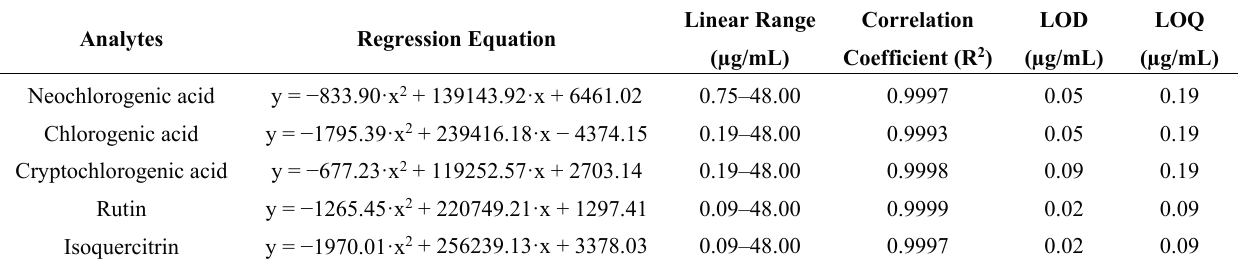
Table 1. Calibration curves, linearity, limits of detection (LOD) and limits of quantification (LOQ) of the five analytes.